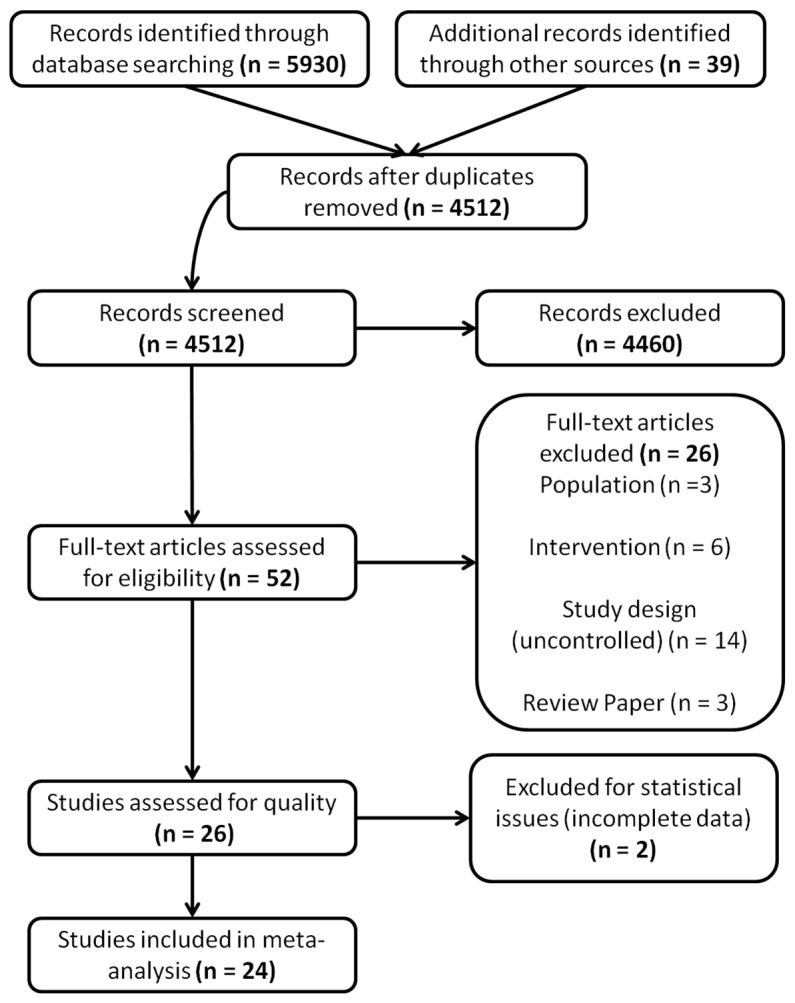
Screening of articles.Four-phase PRISMA flow-diagram for study collection [24], showing the number of studies identified, screened, eligible, and included in the review and analysis.